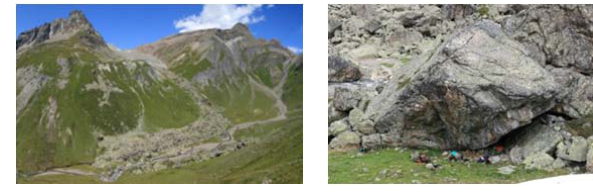
Figure 2: Objects of Interest Left: Plan da Mattun, Rock Stream, Right: Boulder